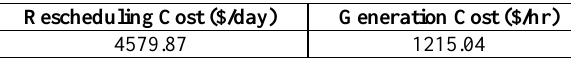
Table 6.Cost of rescheduling and generation cost